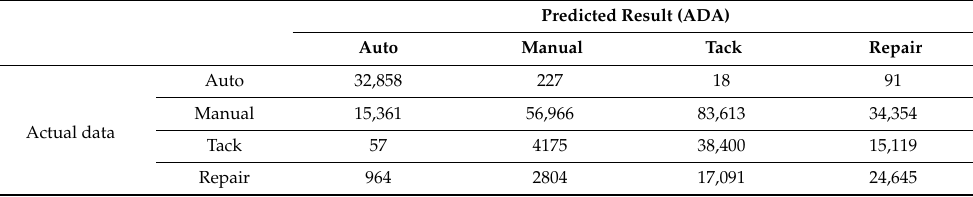
Table 7. Confusion matrix of the ADA classification model.